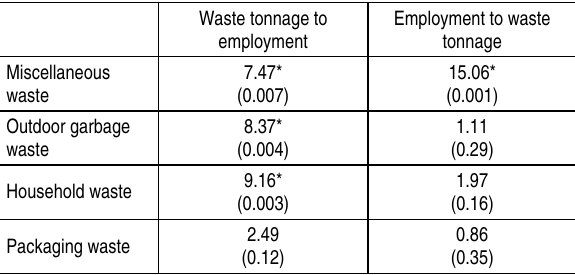
Table 4. Long-run causality test